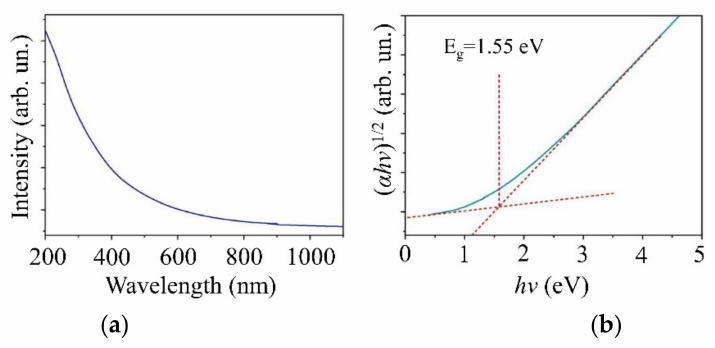
Figure 11. ( a ) Optical absorption spectra and ( b ) Tauc plots for the MoS x ~4 film deposited on sapphire